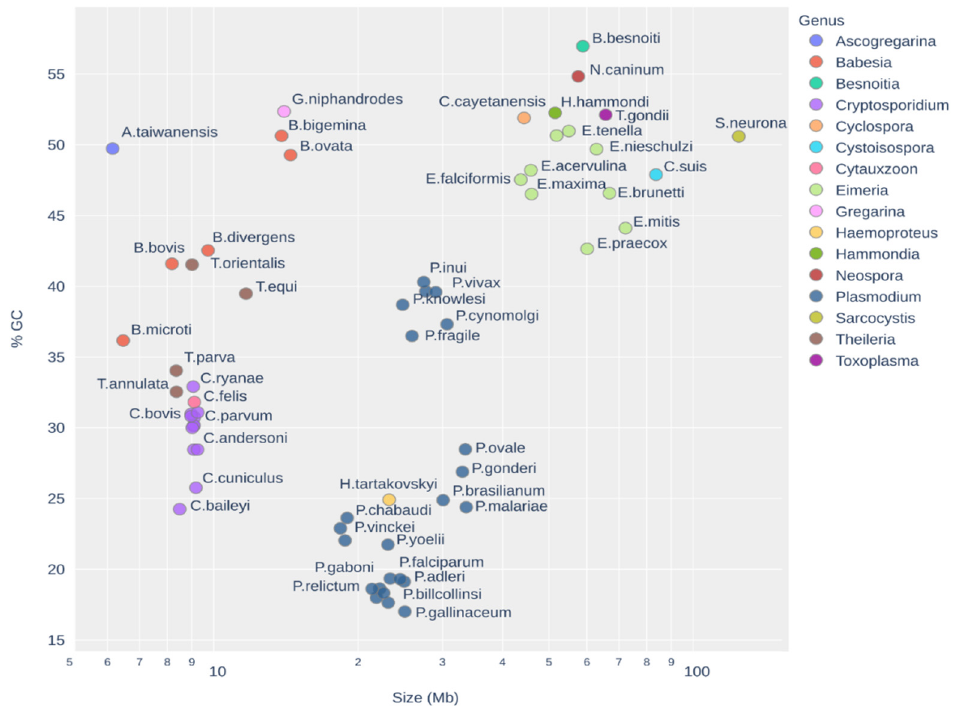
Figure 1. Plot of GC content and genome size (in log scale) used in this work shows the wild diversity of Apicomplexa genomes. For A. taiwanensis, it is estimated that the real genome size is approximately four times larger [7].